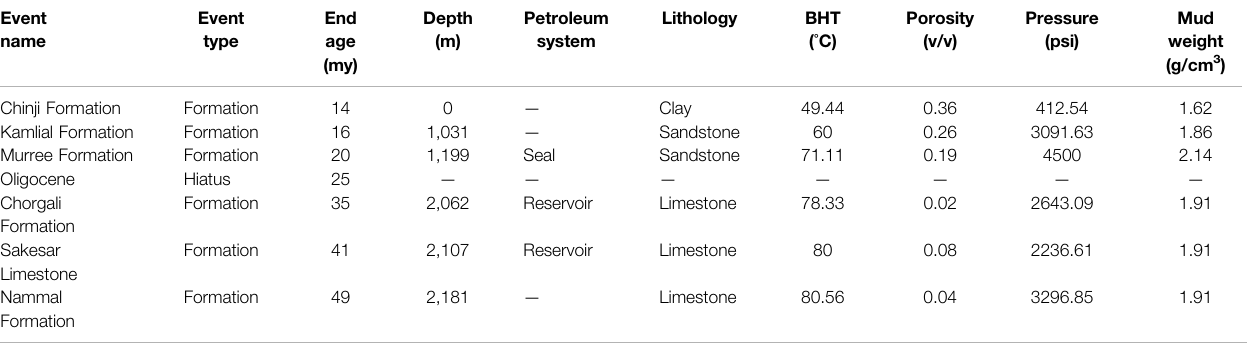
TABLE2| InputparametersusedforthegenerationofburialhistoryplotandpressuresimulationinQazian-1Xwell.GeohistoryanalysisisperformeduptoEoceneageusing data of total seven events (six formations and a hiatus). Lithologies of each formation are mentioned as per stratigraphic information and log results whereas petroleum system components are assigned according to the literature. End age is assigned according to Haq et al. (1987) model. Depth, BHT, porosity, pressure, and mud weight information is obtained from the well